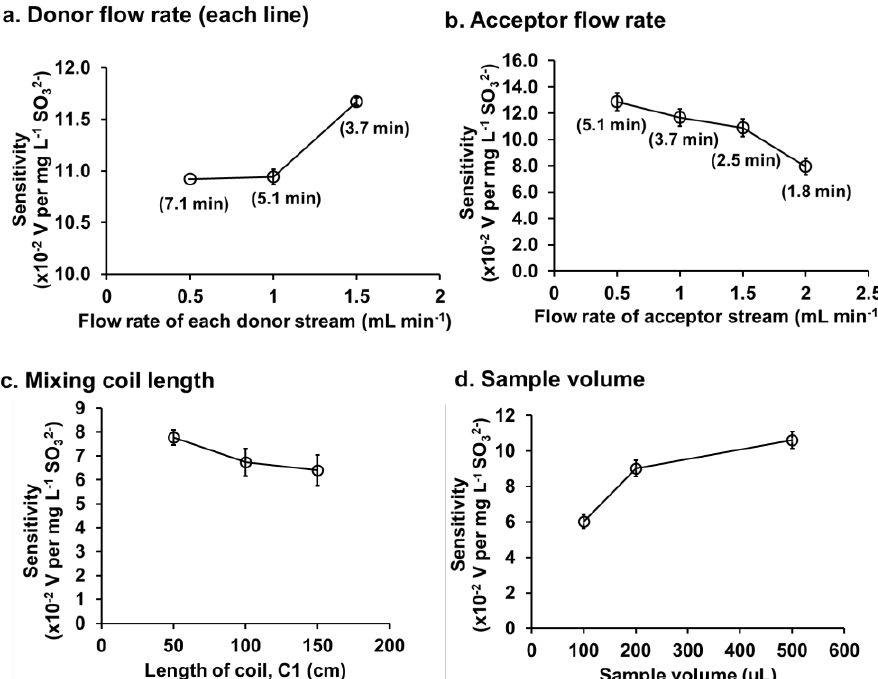
Figure 4. Optimization of physical parameters affecting the sensitivities and analysis time for sulfite analysis. The numbers in parenthesis are analysis time (min) per injection.